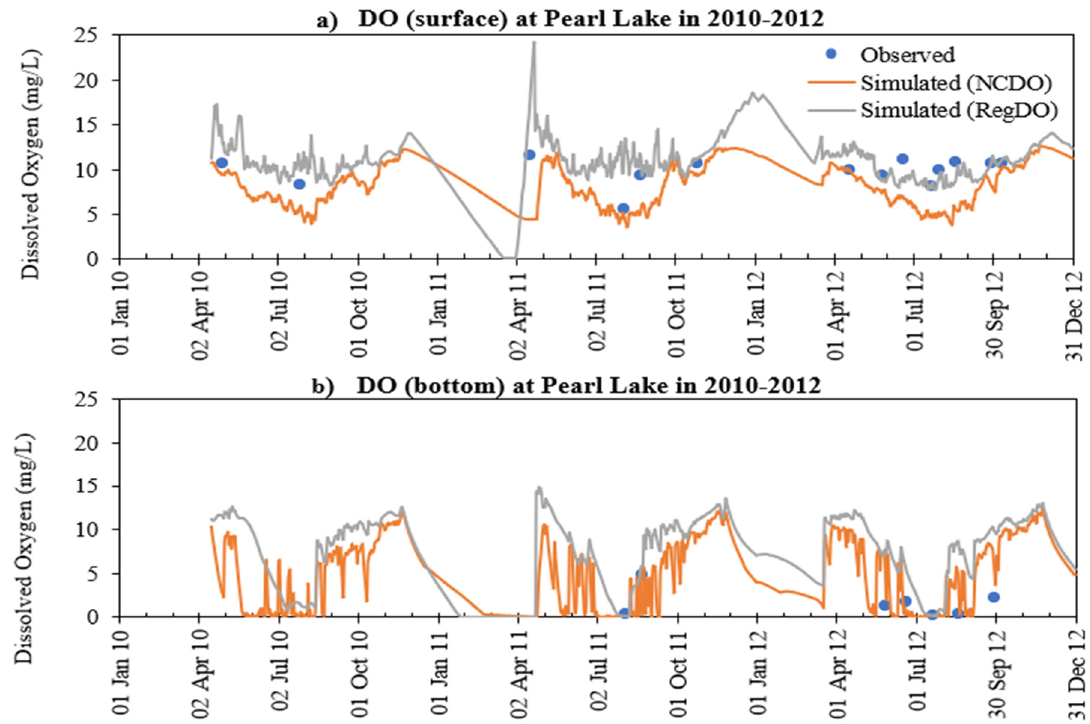
Figure 10. Simulated and observed dissolved oxygen near ( a ) the surface (1 m) and ( b ) bottom (5 m) in Pearl Lake in 2010–2012, respectively.